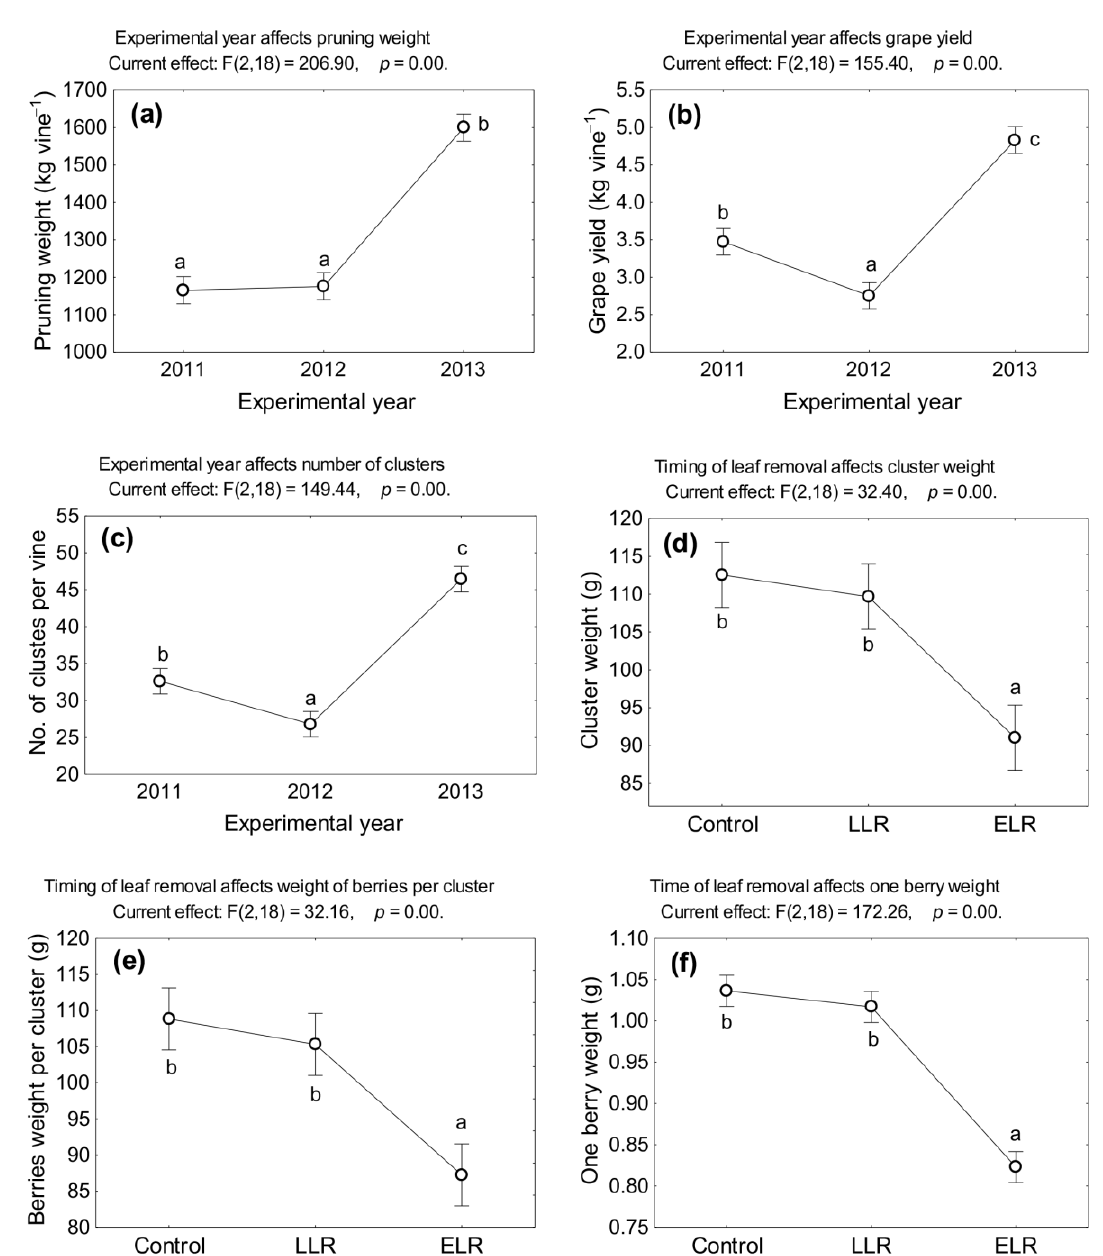
Figure 1. Effect of leaf removal and experimental year on the on the vegetative growth and yield components. ( a ) pruning weight (full model R 2 adj. 0.94, F = 55.7, p = 0.000000); ( b ) grape yield (full model R 2 adj. 0.96, F = 29.4, p = 0.000000); ( c ) number of clusters per vine (full model R 2 adj. 0.92, F = 40.2, p = 0.000000); ( d ) cluster weight (full model R 2 adj. 0.78, F = 12.5, p = 0.000006); ( e ) weight of berries per cluster (full model R 2 adj.0.77, F = 12.2, p = 0.000007); ( f ) weight of one berry (full model R 2 adj. 0.93, F = 45.0, p = 0.000000). Mean values marked with the same letter are not significantly different at α = 0.05. Vertical bars denote 95% confidence